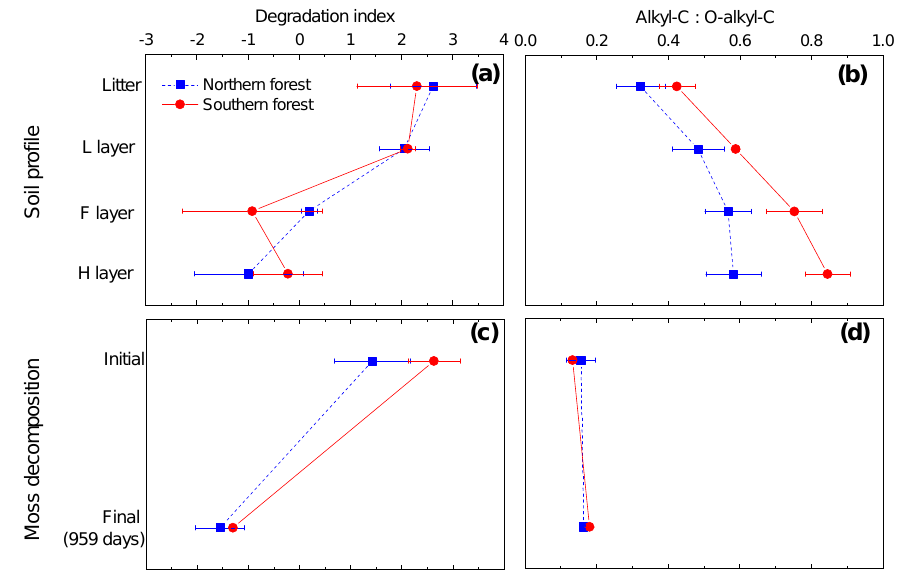
Figure 8. Panels (a) and (b) show the degradation index and alkyl-C : O − alkyl-C ratio for the soil profile in the cooler region (blue squares) and warmer region (red circles). Degradation index data from Philben et al. (2016). Panels (c) and (d) are calculated from this incubation data to contrast two methods for determining level of degradation for mosses. Data points are given as the mean, with standard deviation displayed as error